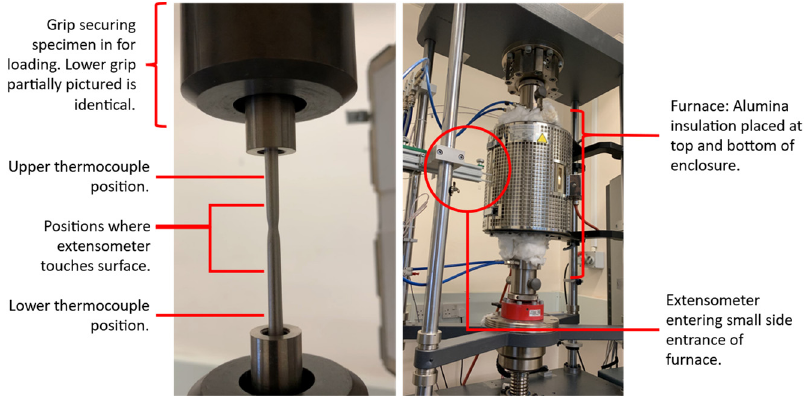
Figure 1. Labelled diagram of the experimental setup, highlighting sample installation and furnace enclosure. The specimen shown is from a previous experiment but serves the purpose of setup description effectively.